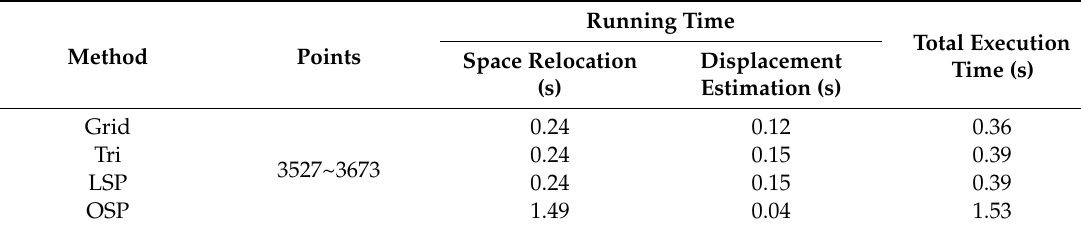
Table 10. Comparison of execution time between the four methodologies.